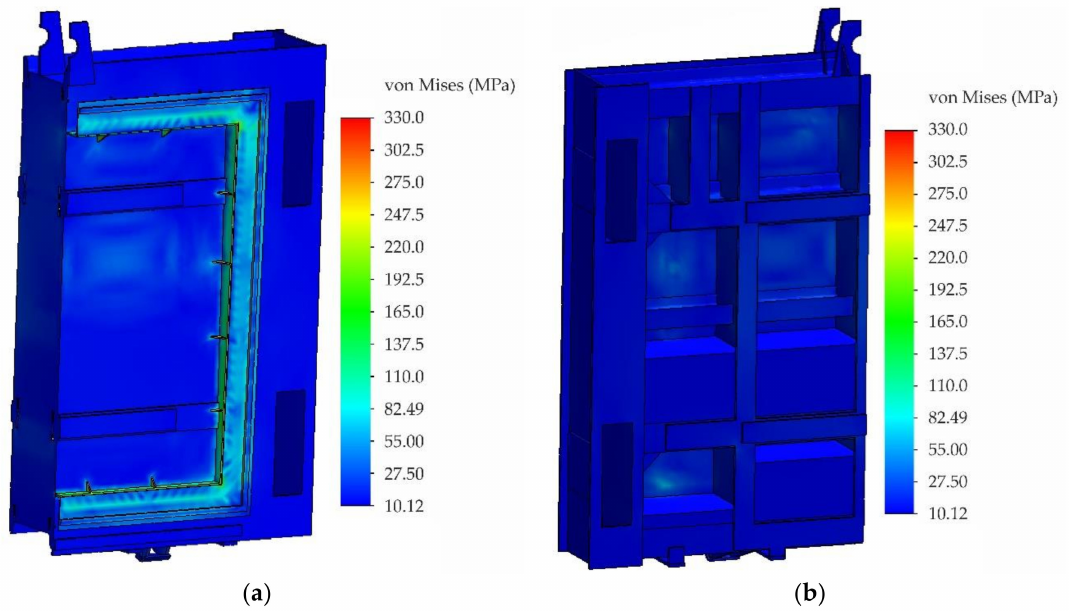
Figure 19. Fields of equivalent stresses according to von Mises theory: ( a ) front view and ( b ) rear